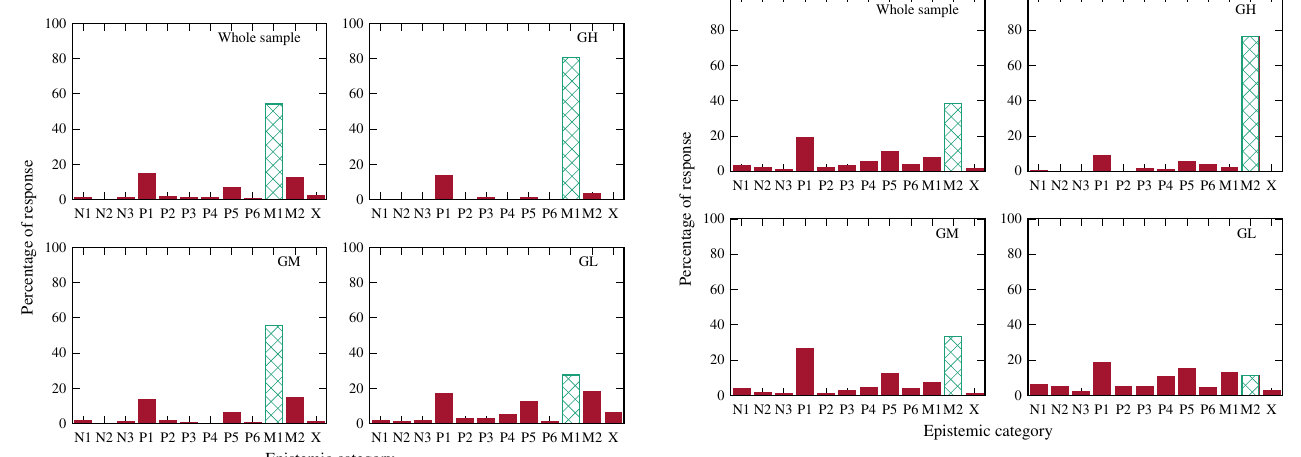
FIG. 12. Aggregate distribution of responses to the only proposition (S23) corresponding to epistemic category M1. Format of the figure is the same as in Fig. 4.